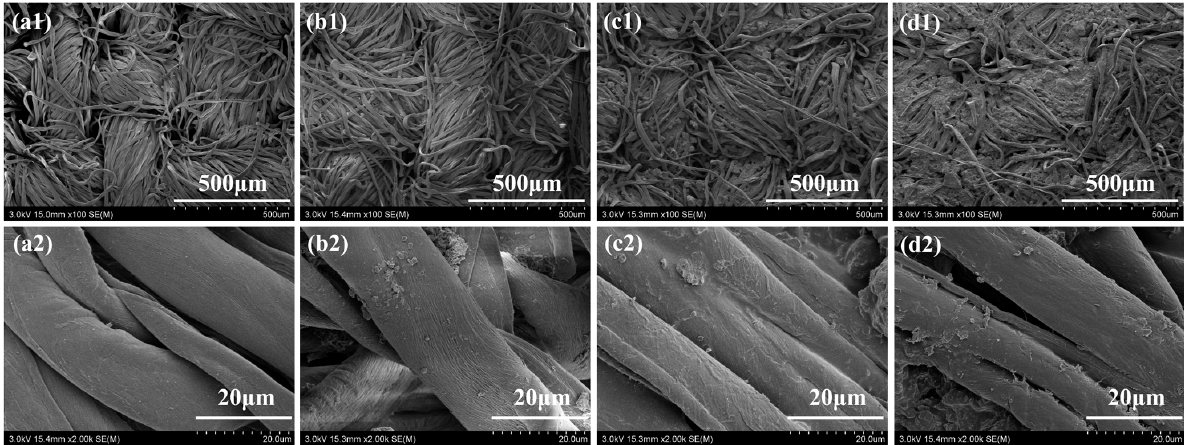
Figure 2. SEM images of all cotton fabrics: ( a ) Control, ( b ) Cotton ‐ 2TL, ( c ) Cotton ‐ 5TL, ( d ) Cotton ‐ 8TL. ( d1 , d2 )